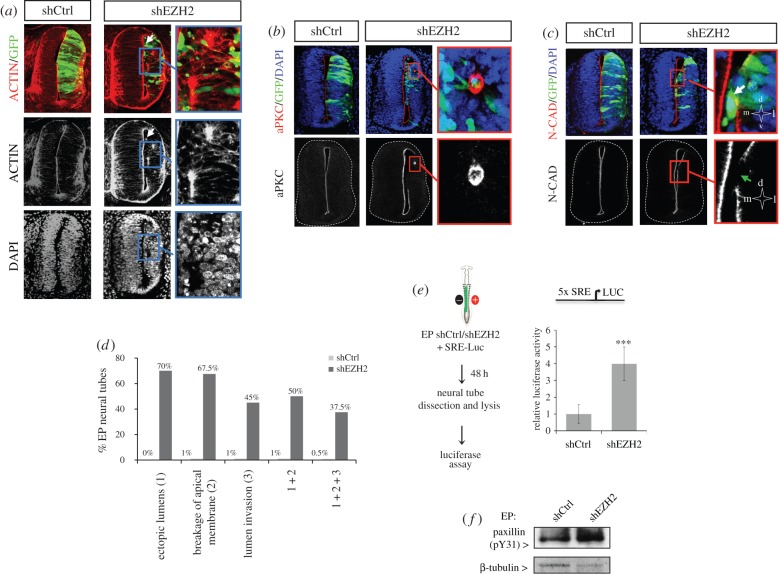
EZH2 preserves NE structure. (a–c) Transversal sections of neural tubes from HH11–12 embryos electroporated in ovo with shCtrl or shEZH2 and stained with phalloidin-rhodamine (a), aPKC (b) or N-cadherin (N-CAD, c) antibodies and DAPI 48 h PE. The results are representative of at least four independent experiments. White arrows mark progenitor cells that have lost the apicobasal polarity and have occupied the lumen. Green arrow indicates area where the apical membrane was severely disrupted along the luminal surface. (d) Graph shows the quantification of the morphological alterations observed in electroporated neural tubes. Data represent the percentage of n = 51 sections (from three to four embryos). (e) HH11–12 embryos were electroporated in ovo with shCtrl or shEZH2 together with pSRE-luc plasmid [24–26] and β-gal reporter used as internal control; 48 h PE the neural tubes were dissected out, the tissue was disaggregated and the luciferase activity measured using the Life Technologies dual kit. Data represent mean of three experiments from five to seven embryos. Error bars indicate s.d. ***p < 0.001. (f) HH11–12 embryos were electroporated in ovo with shCtrl or shEZH2; 48 h later GFP+ neural cells were FACS purified. Total protein extracts were prepared and the levels of paxillin (pY31) were determined by western blot. β-Tubulin levels were used to normalize the protein content.